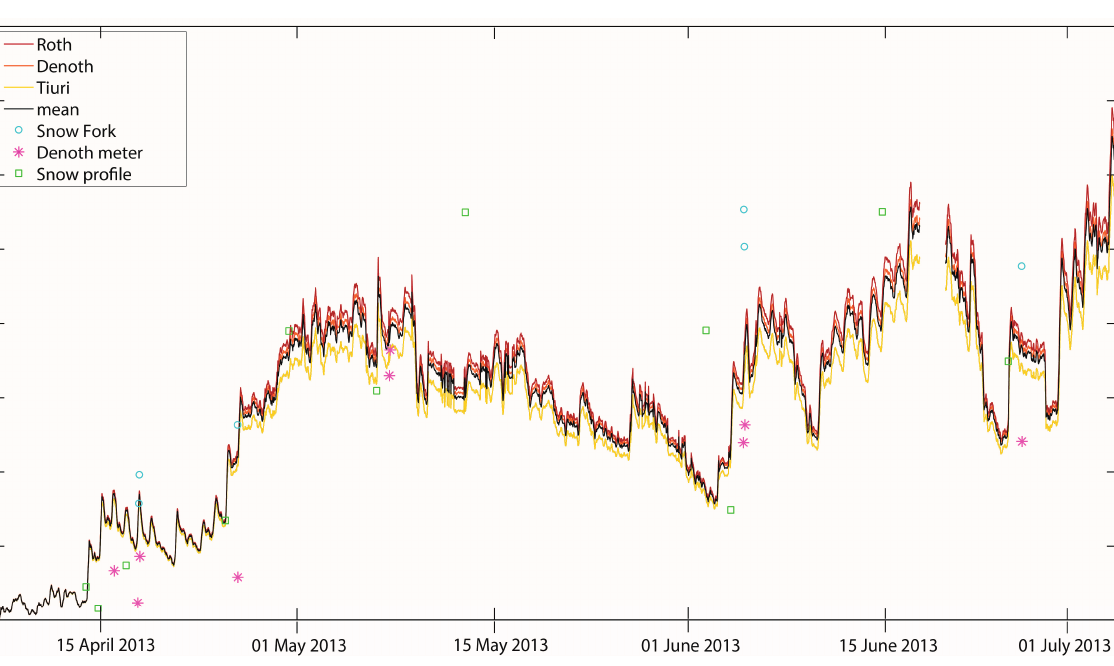
Figure 7. Bulk volumetric LWC of the snowpack above the antennas of GPS2 and GPS3 at the Weissfluhjoch test site for the period 7 April–6 July 2013, calculated with the normalized GPS C/N 0 data. The LWC was calculated with three different formulations (Roth, Denoth and Tiuri). Furthermore, the mean of the three curves, as well as reference measurements with the Snow Fork, the Denoth meter and the estimate from manually observed snow profiles are